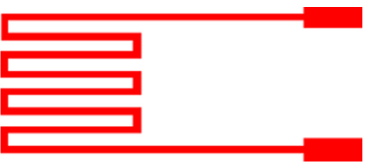
Figure 1. Schematic diagram of resistive micro temperature sensor.